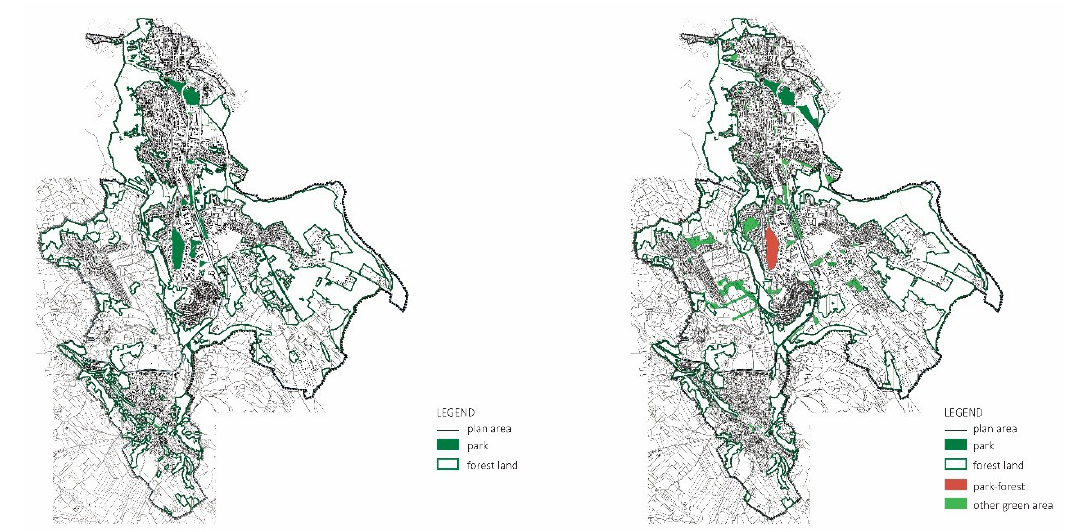
Figure 4. General zoning plan for Bor: green spaces land use plan, current vs. planned state (source: Authors).